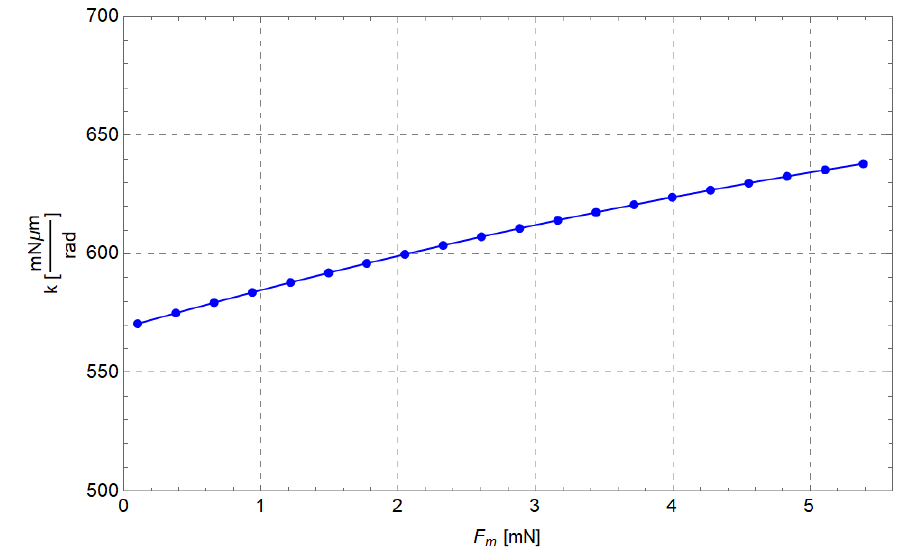
Figure 12. Curved beam stiffness ( k ) vs input force ( F m